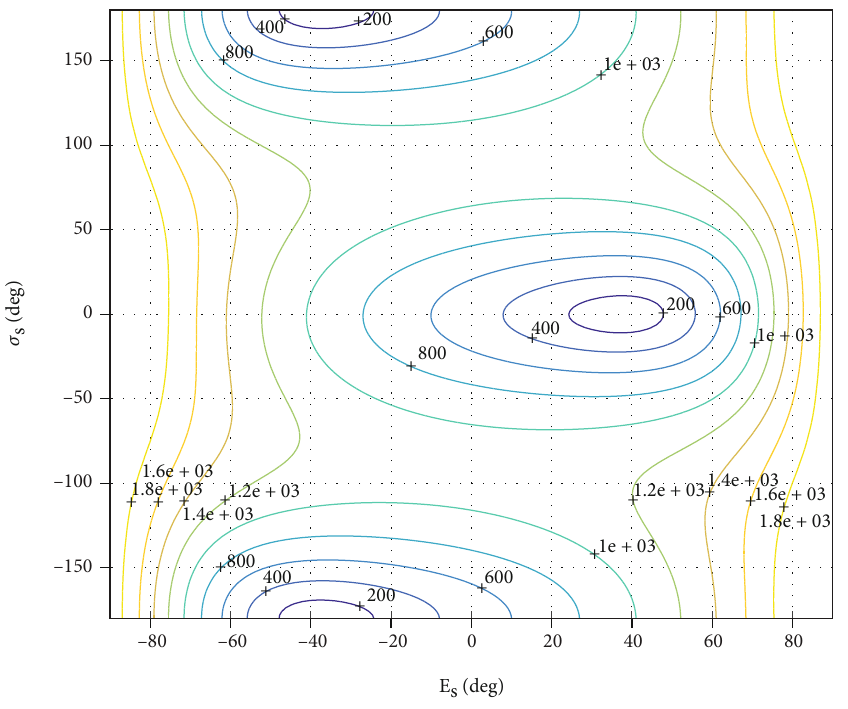
Figure 7: Composite guidance CEP contour map for